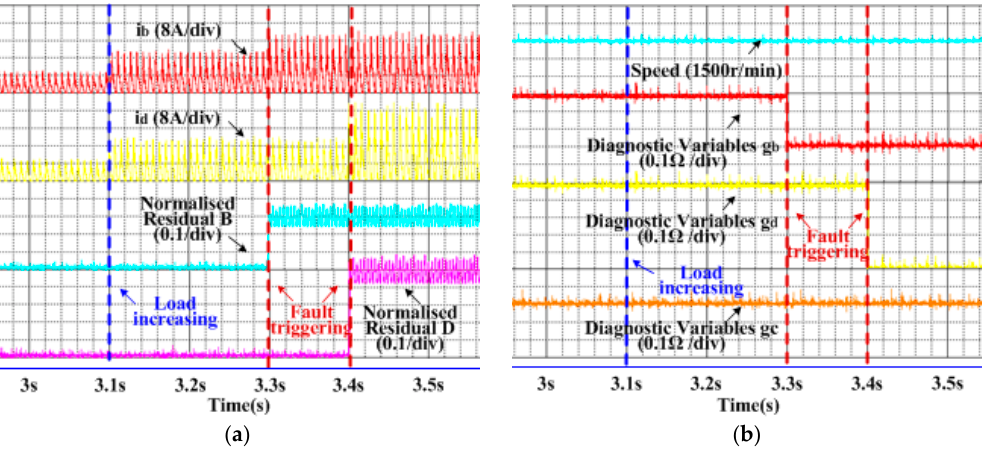
Figure 10. Experimental results in the case of a multiphase winding fault of the SRM at high speed and